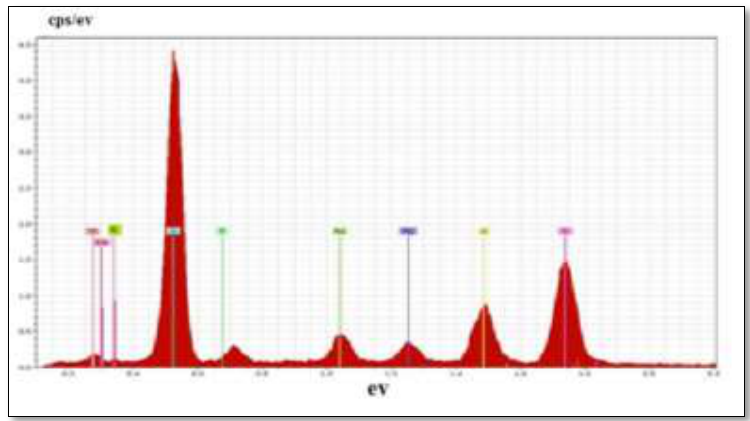
Figure 8: explain Kaolin before exposure thermal treatment.